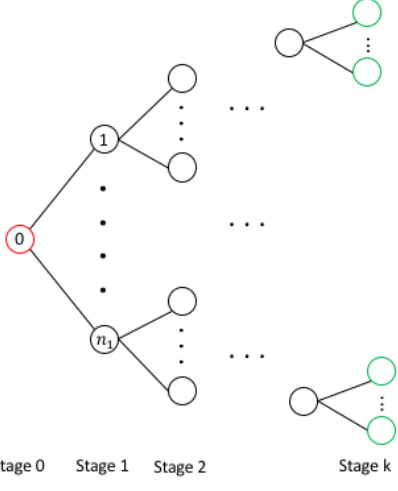
Figure 4. The regime switching model